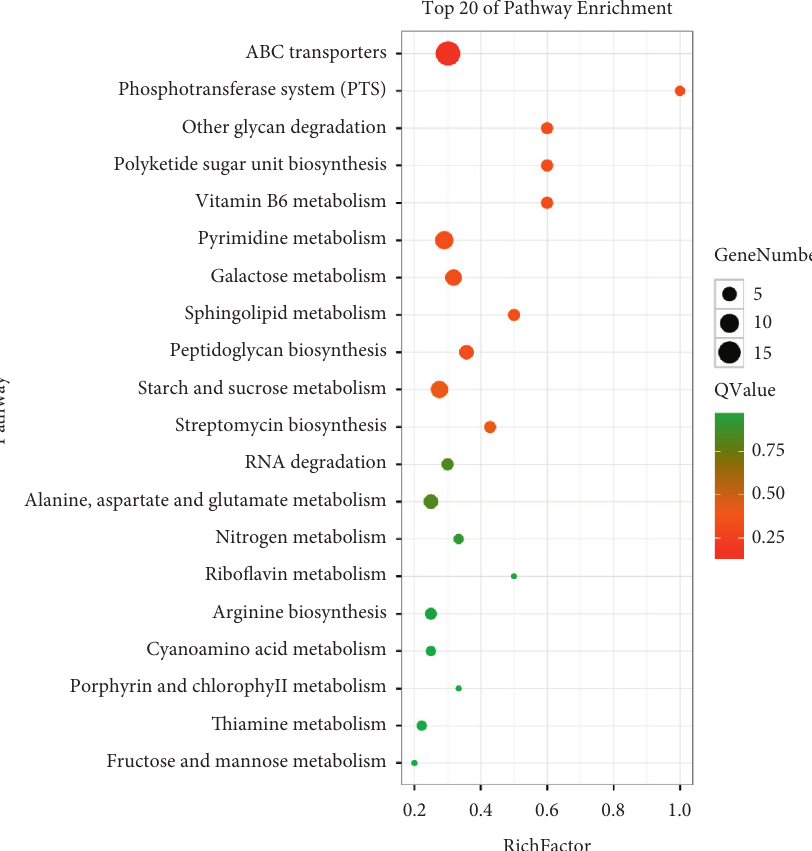
Figure 2: KEGG pathway enrichment analysis of DEGs (X2/X3 vs. X5). The vertical axis indicates the name of the KEGG pathway, and the horizontal axis indicates the rich factor. The dot size indicates the number of differentially expressed genes in the pathway, and the color of the dots corresponds to different Q